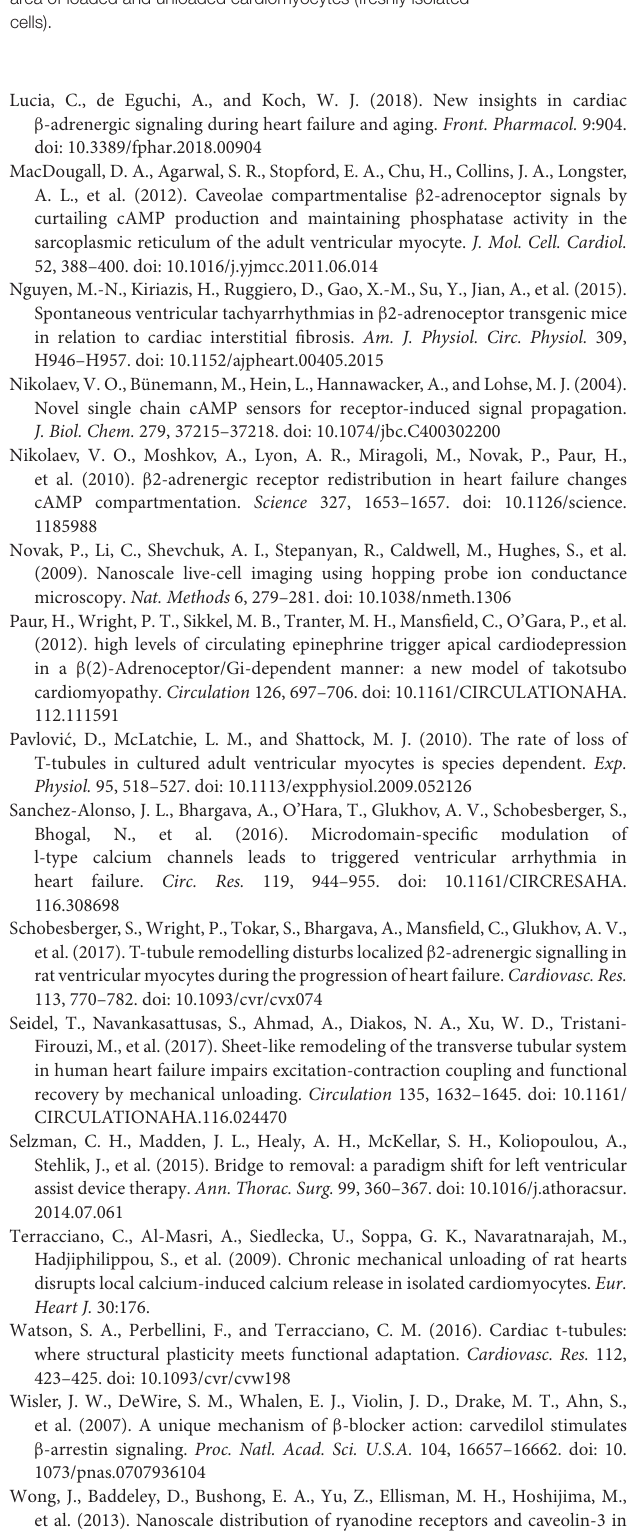
FIGURE S3 | (A) Example image showing a loaded cardiomyocyte stained with di8ANNEPPS (freshly isolated cells). (B) Example image showing an unloaded cardiomyocyte stained with di8ANNEPPS (freshly isolated cells). (C) Graph comparing the density of di8ANNEPPS staining in loaded and unloaded cardiomyocytes (freshly isolated cells). (D) Graph comparing the regularity of